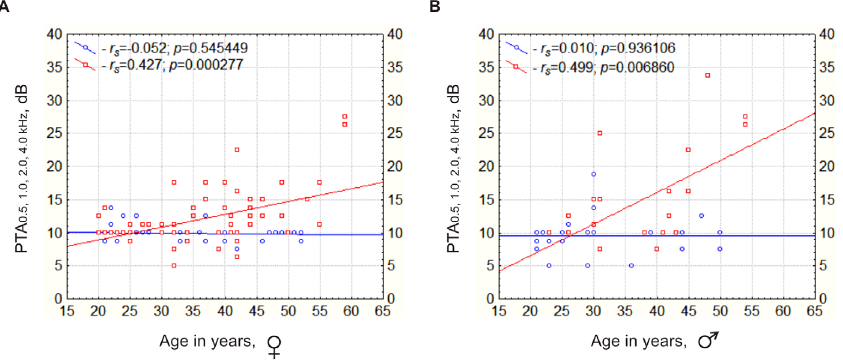
Figure 2. The correlation of increase of hearing thresholds according to age in individuals with genotype IVS1 + 1G . A/wt. Note: Y- axis – hearing thresholds (dB), X-axis – age in years; r s – the Spearman’s rank correlation coefficient, p – statistical significance of Spearman’s rank correlation; blue circles – individuals with GJB2 genotype wt/wt, red squares – individuals heterozygous for mutation (genotype IVS1 + 1G . A/wt); blue line shows the absence of hearing thresholds correlation with age in individuals with GJB2 genotype wt/wt, red line – the linear regression of increase in hearing thresholds according to age in individuals with GJB2 genotype IVS1 + 1G . A/wt; A – R female, B – = male.